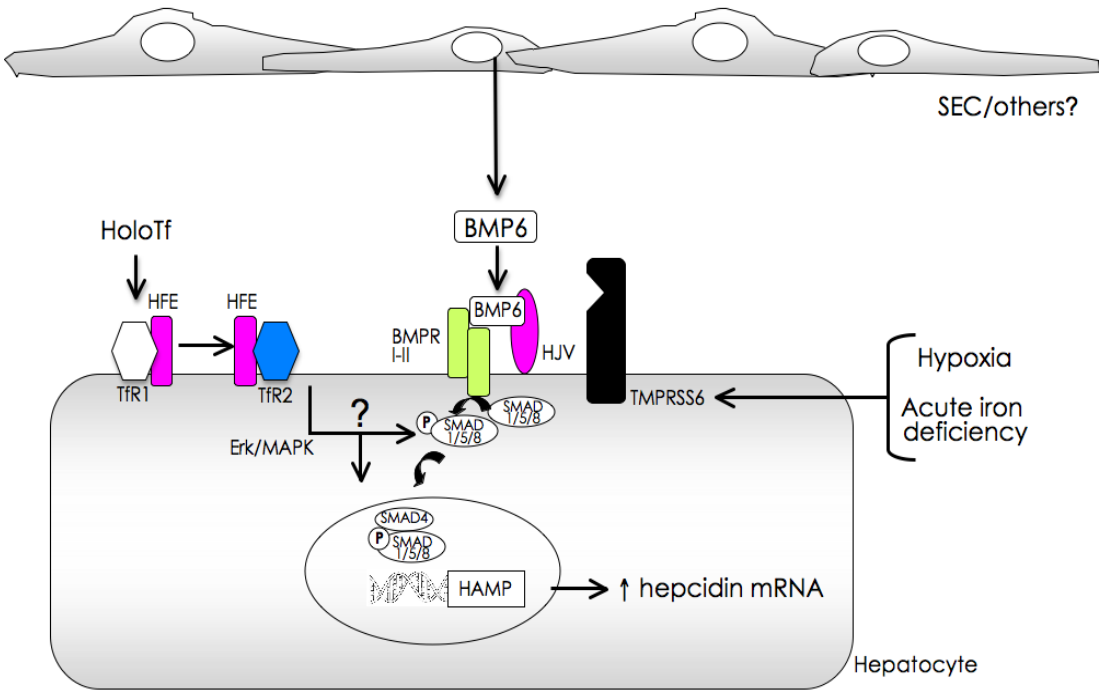
FIGURE 1. Modulation of hepcidin transcription by iron. Diferric (Holo) transferrin binds to its receptor TfR1 and leaves HFE free to interact with TfR2, which is stabilized on the cell surface. Interaction between HFE and TfR2 modulates hepcidin transcription through a mechanism not yet fully clarified. BMP6 is produced mainly by SEC (sinusoid endothelial cells) and other nonparenchymal cells[10], and is transcriptionally activated by intracellular iron increase. The hepatocyte-specific BMP coreceptor HJV binds to BMP receptors type I and II (BMPRI-II) in the presence of the ligand BMP6. Formation of the multiprotein complex on the cell surface of hepatocytes activates the phosphorylation of SMAD1/5/8 and their interaction with SMAD4. The SMAD complex translocates to the nucleus for hepcidin activation. Conditions of hypoxia/acute iron deprivation increase the activity of the transmembrane serine protease TMPRSS6, which impairs hepcidin mRNA by cleaving membrane